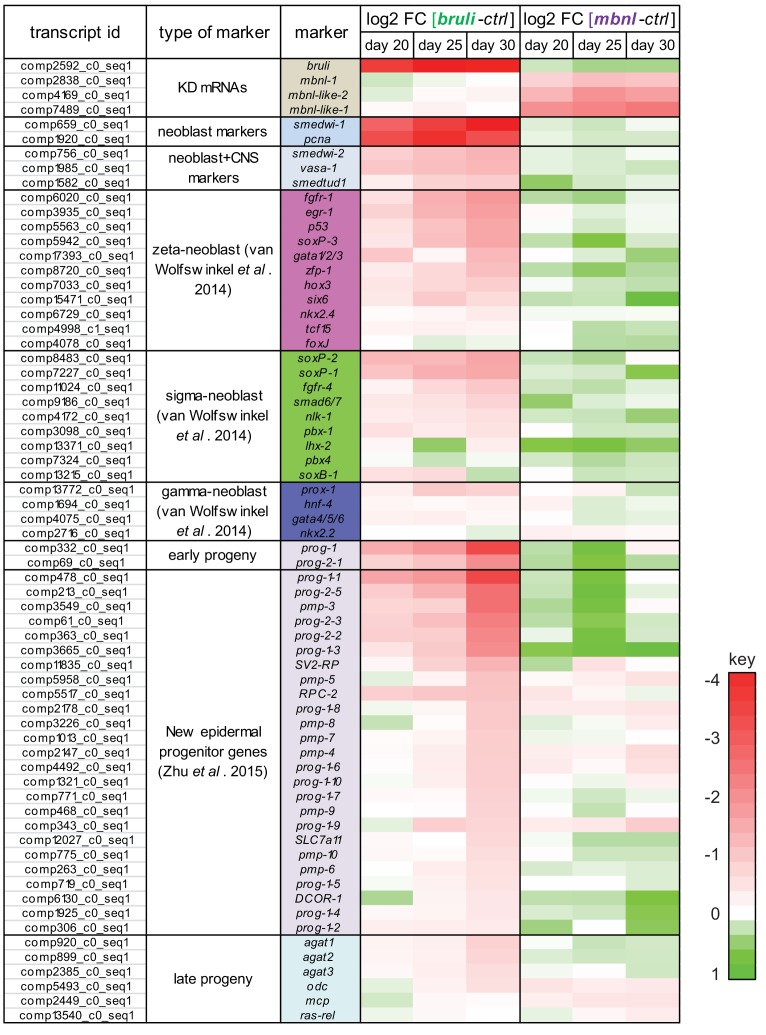
bruli and mbnl knockdown have contrasting effect of specific gene markers.Log2 fold change in gene expression of key markers 20, 25 and 30 days after bruli (left) or mbnl (right) treatment, measured from RNA-Seq. Red/Green intensities indicate different levels of down/up regulation. bruli and mbnl knockdown have distinct effects on different types of markers. In particular, they show antagonistic effects of 'Early progeny' markers.